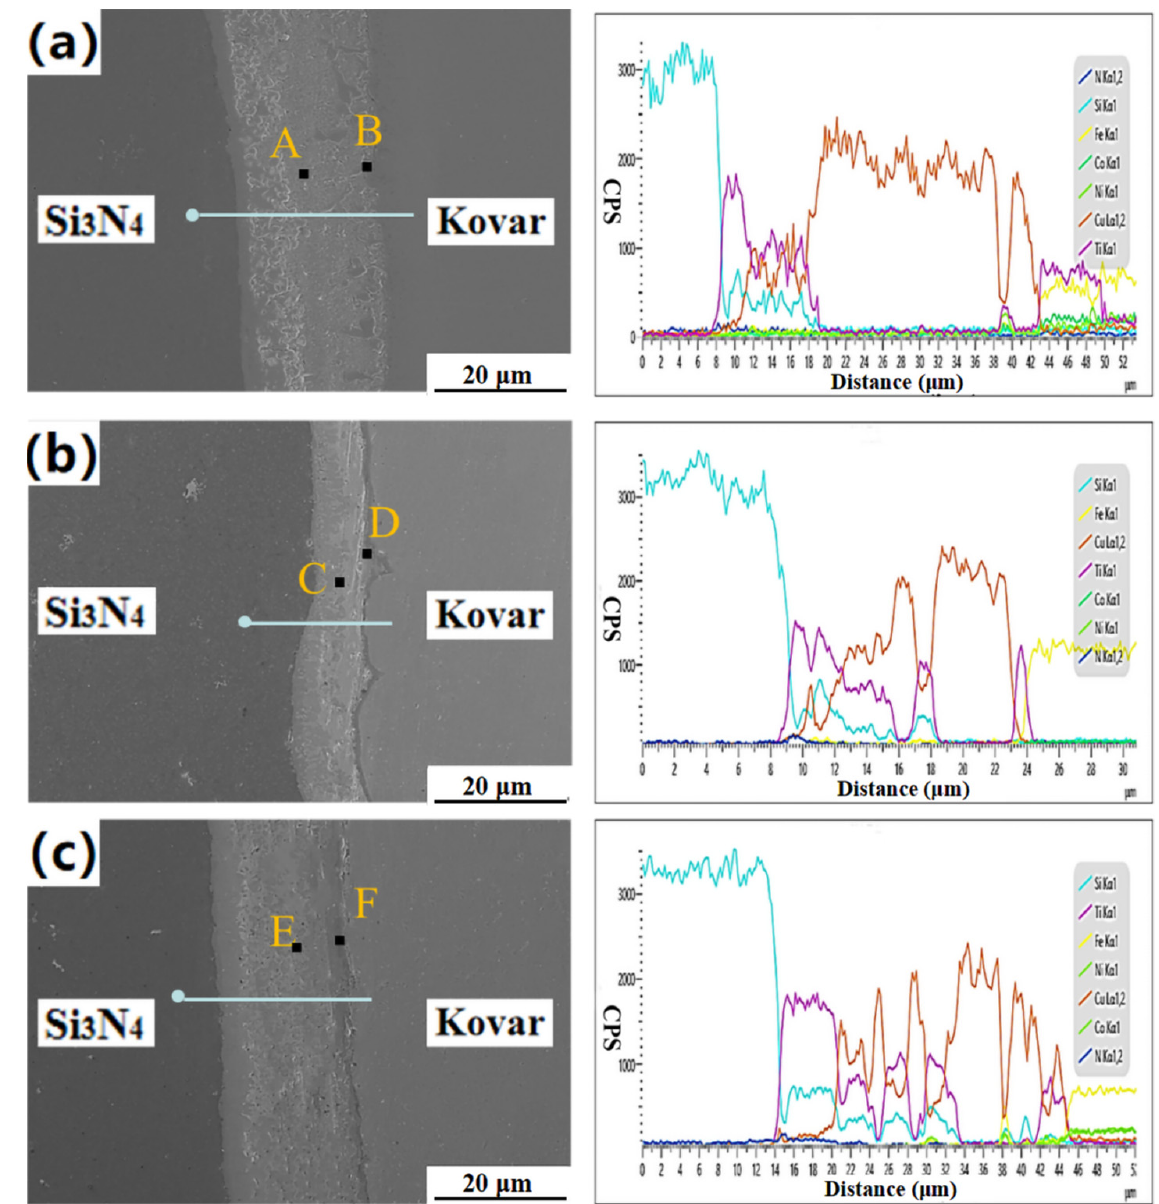
Figure 10. Microstructure and line scan analysis of Si 3 N 4 /Ti/Cu/Kovar joint under different holding times: 1 h ( a ), 2 h ( b ), or 3 h ( c ).